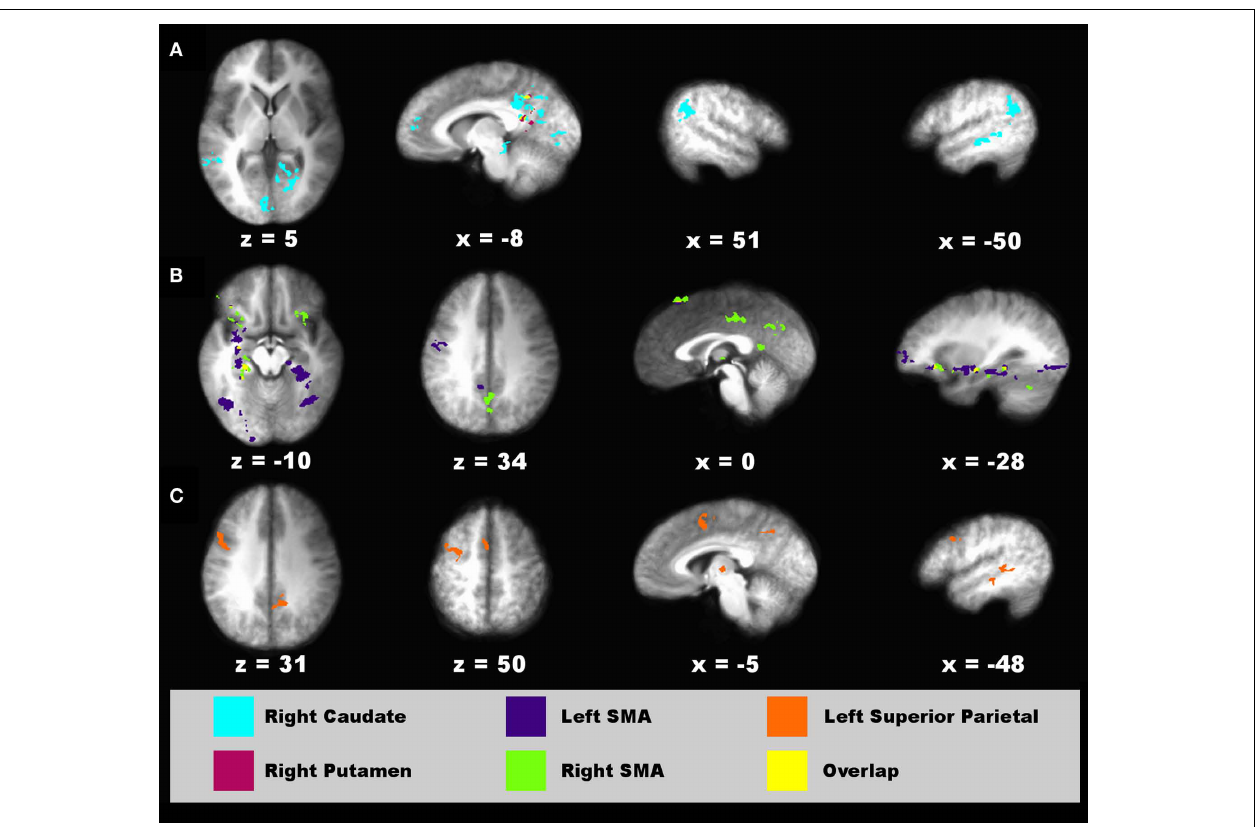
area (SMA) seeds. (C) Left superior parietal cortex seed (orange).The spatial overlap between two seeds in their interacting regions (A,B) is shown in yellow. Coordinates beneath sagittal and axial sections represent the distance in millimeter from the anterior commissure: x , right ( + )/left ( − ); superior ( + )/inferior ( − ). See Table 2 for details about individual activation